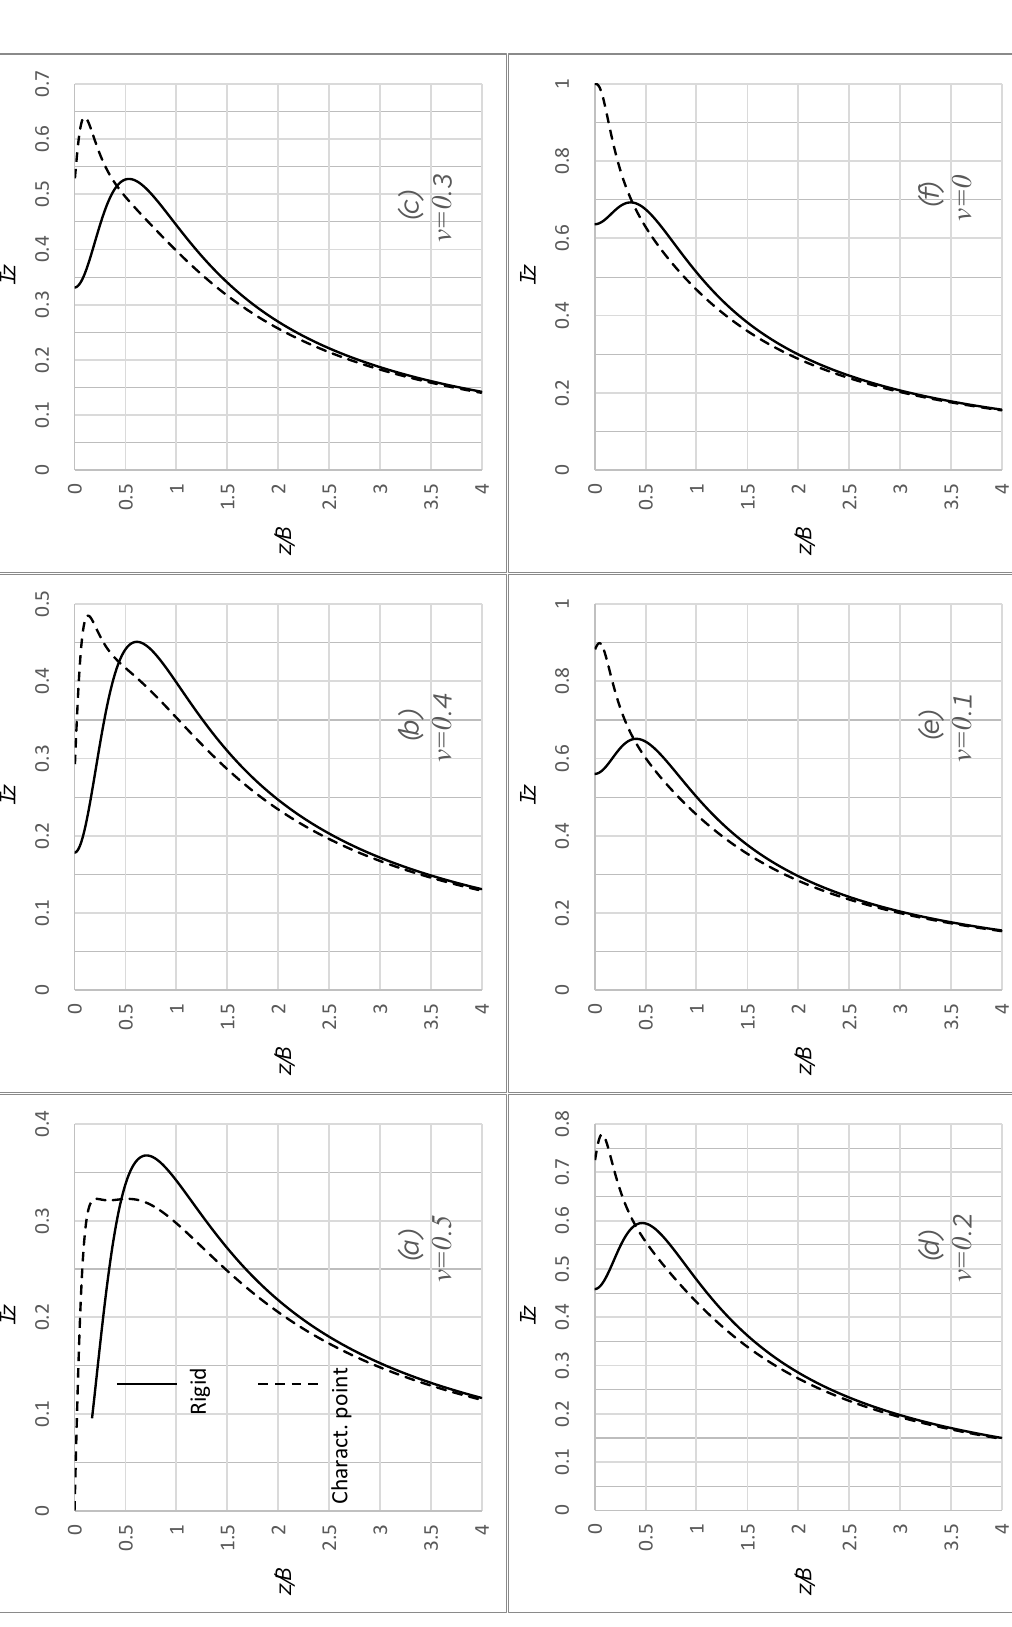
Figure 12. I z versus normalized depth charts for various ν values of soil (( a )–( f ) for ν = 0 to 0.5 with 0.1 interval), comparing the case of rigid strip footing with the respective flexible strip footing at the characteristic point.